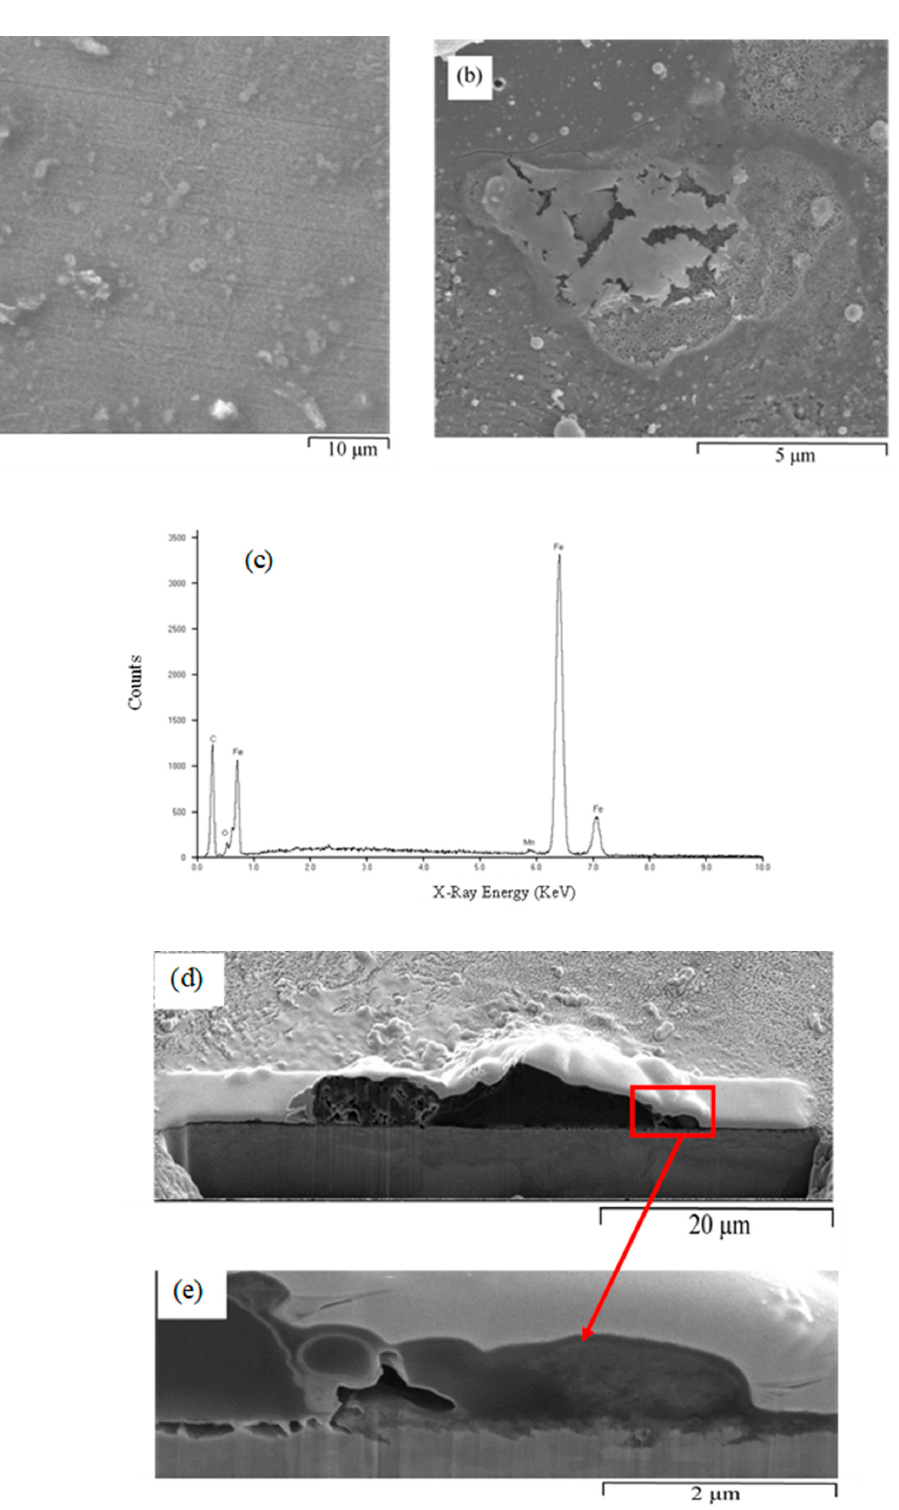
Figure 5. ( a ) ESEM and ( b ) SEM images of biofilm formed on carbon steel by a pure IRB culture (168 h exposure time to Postgate C medium). ( c ) EDS analysis of the biofilm corresponding to the ESEM image. ( d ) FIB-SEM images of the cross-section and ( e ) initial layer of fibrous EPS material produced by